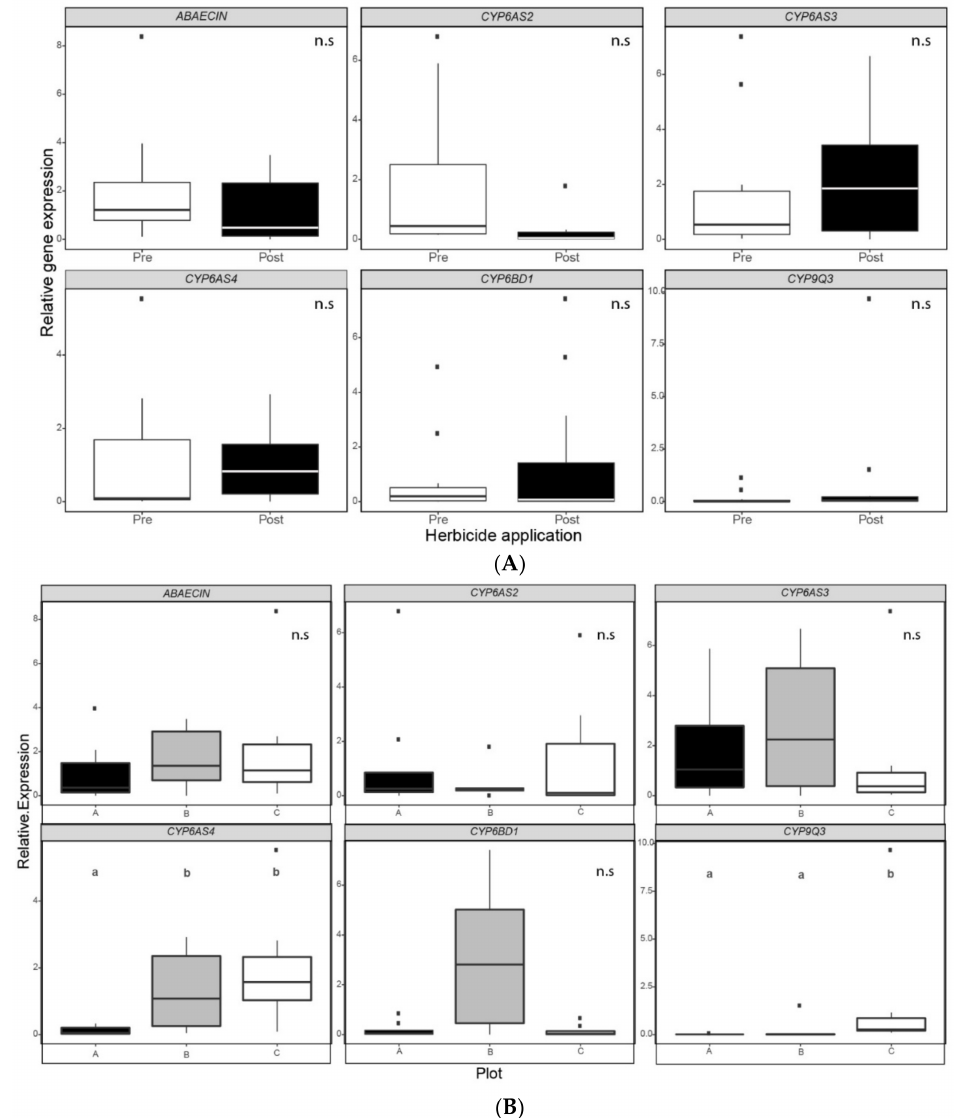
Figure 3. Gene expression in hive bees’ midguts ( A ) before and after post-emergence weed control and ( B ) for each plot. Relative expression levels of the antimicrobial peptide Abaecin (AB) and P450 cytochromes ( CYP6AS2 , CYP6AS3 , CYP6AS4 , CYP6BD1 and CYP9Q3 ) in ten pooled midguts of hive bees captured inside randomly selected colonies. Transcription was assessed by real-time quantitative reverse transcription amplification (qRT-PCR). Data are presented as a fold change expression normalized to the endogenous reference gene Rpl8 , calculated by ∆∆ CT method. Boxplots show the median and interquartile range (IQR), with whiskers showing the maximum value within 1.5 IQR, and individual points mark values outside this range. Different letters indicate significant differences between plots ( p < 0.001, N = 12, Friedman rank sum test). No significant differences (n.s.) were found between application moments for any of the genes studied (N = 12, Wilcoxon paired